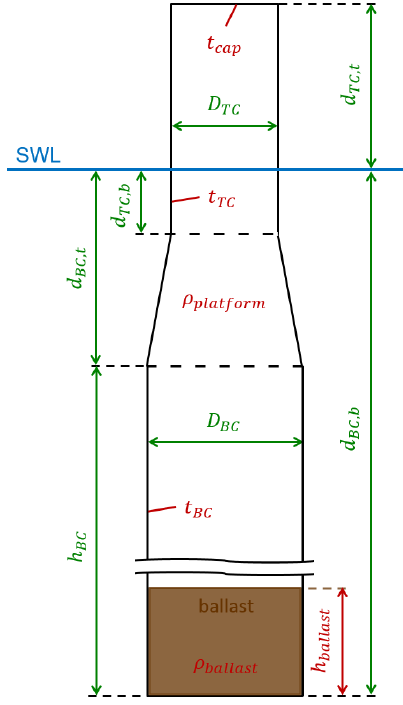
Figure 3. Schematic of the OC3